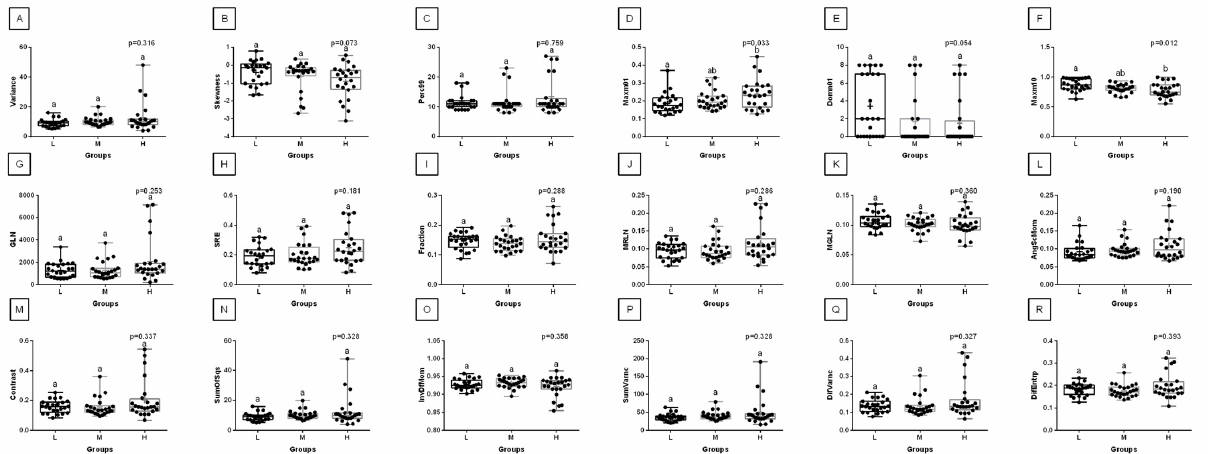
Figure 11. Analysis of texture features for the blue component compared between light (L), moderate (M), and heavy (H) groups in the third region of interest (ROI 3). Differences between groups were indicated with individual p -values when p < 0.05. Different superscripts on each plot were statistically different. ( A ) Variance; ( B ) Skewness—skewness coefficient; ( C ) Perc99—percentile; ( D , F ) Maxm01, Maxm10—maximum of moments; ( E ) Domn01—dominant; ( G ) GLN—gray level non-uniformity; ( H ) SRE—short-run emphasis; ( I ) Fraction—a fraction of image in runs; ( J ) MRLN—run-length nonuniformity moment; ( K ) MGLN—gray level non-uniformity moment; ( L ) AngScMom—angular second moment/energy; ( M ) Contrast; ( N ) SumOfSqs—sum of squares; ( O ) InvDefMom—inverse different moment/homogeneity; ( P ) SumVarnc—summation variance; ( Q ) DifVarnc—differential variance; ( R ) DifEntrp—differential entropy. Data are presented using minimum and maximum values, lower and upper quartiles, and median. The mean value is marked by a cross.